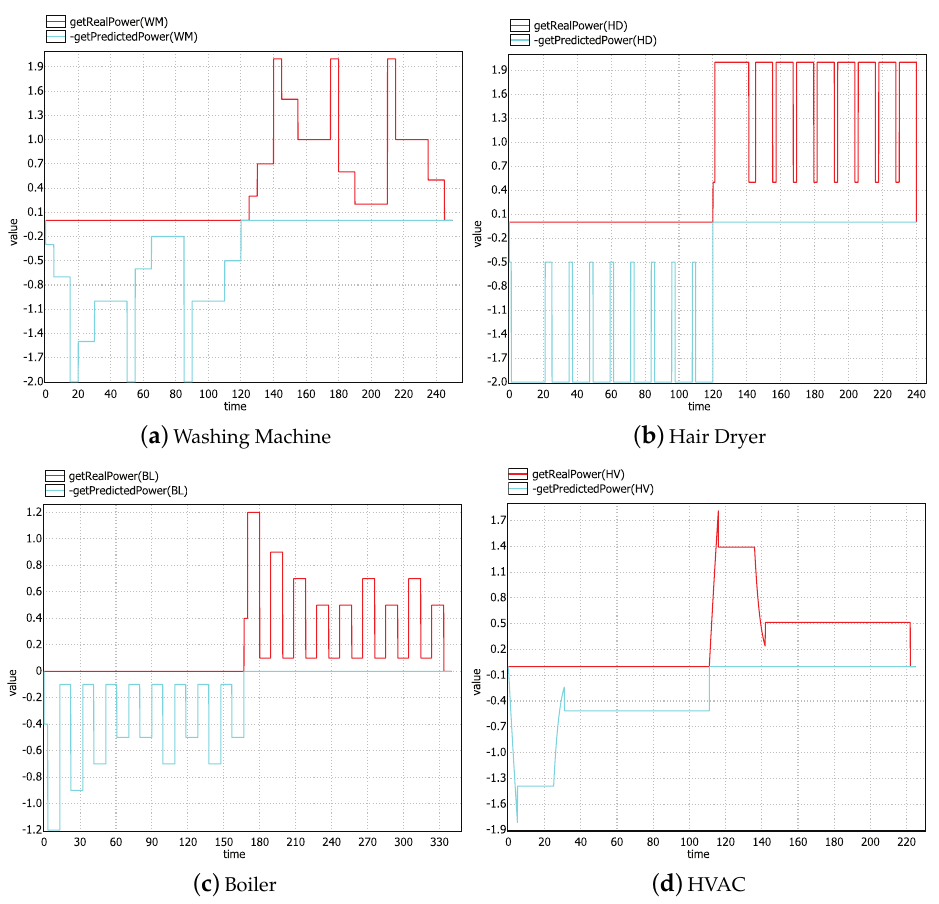
Figure 2. ( a – d ) The consumption curve (in KW) of the considered appliances vs. time.